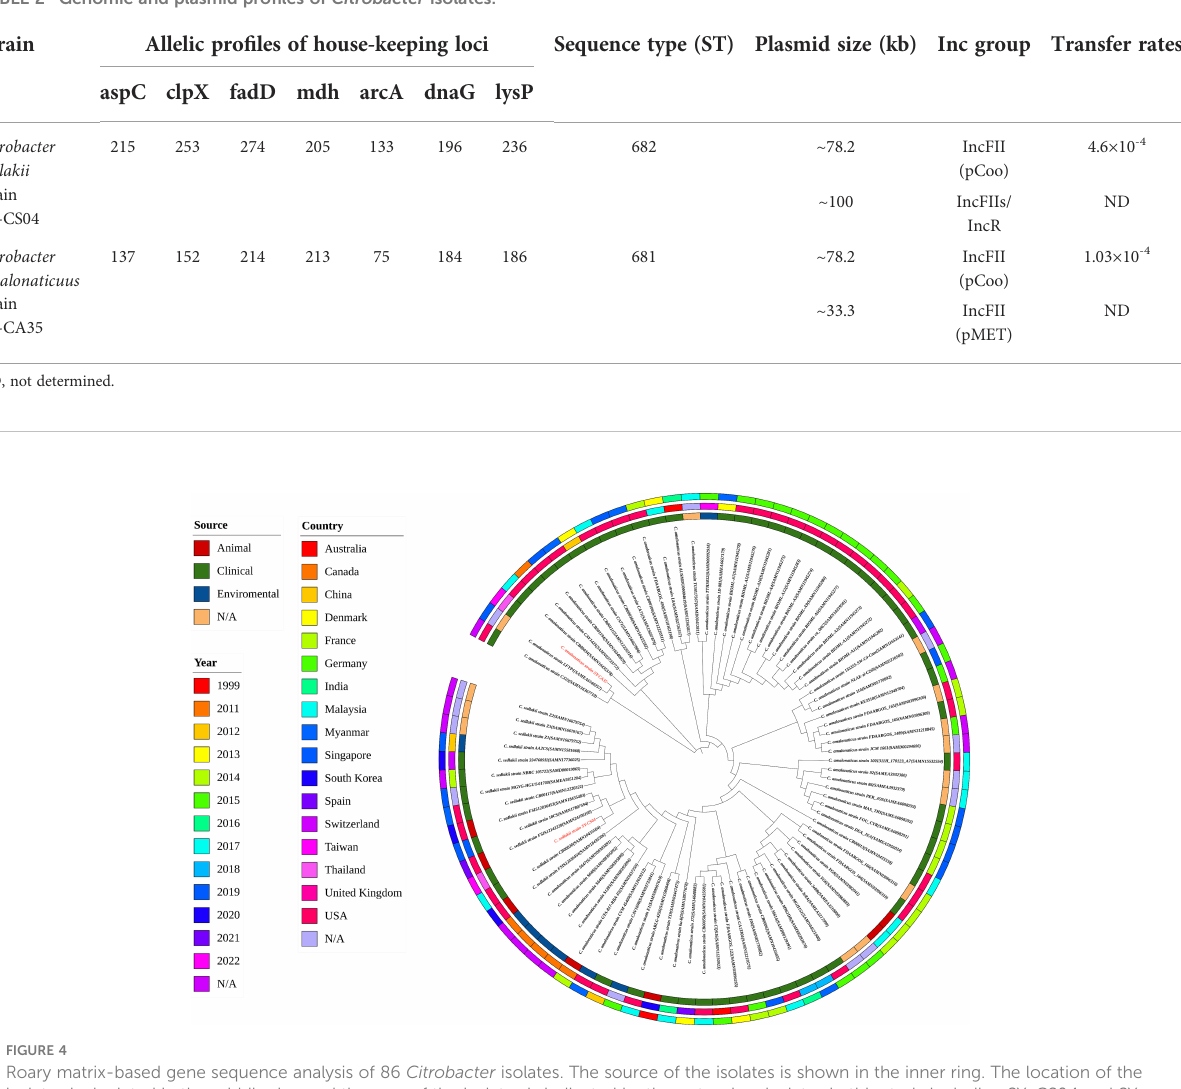
TABLE 2 Genomic and plasmid pro fi les of Citrobacter isolates.